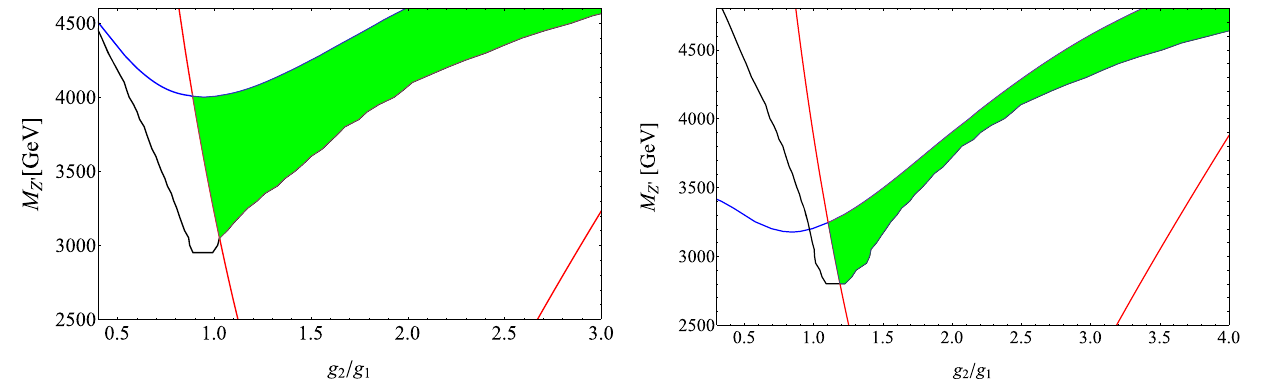
areexcludedbythecurrentLHClimitsandtheambiguityofthe Z boson (cid:9) M / 2. mass, respectively. Top-left panel: z 1 = 1 / 4 and z 2 = 1 / 8. Top-right Z (cid:2) 3 R panel: z 1 = 1 / 5 and z 2 = 1 /